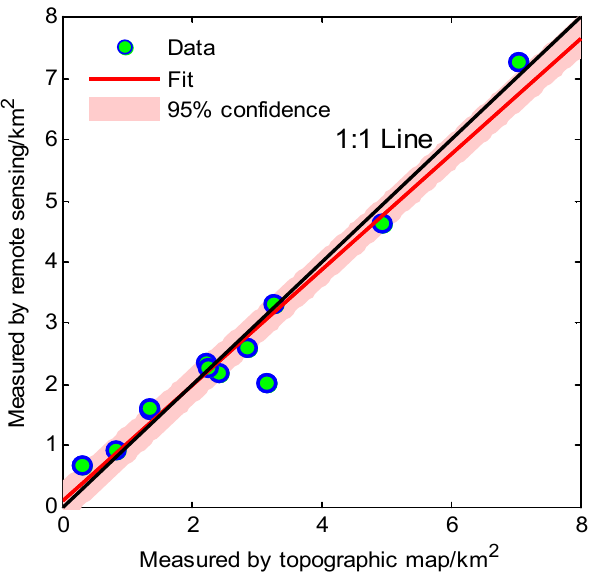
Figure 18. Scatter plot of the extent of the wall reconstructed from historical topographic maps, and the extent of the wall reconstructed from remote sensing imagery.